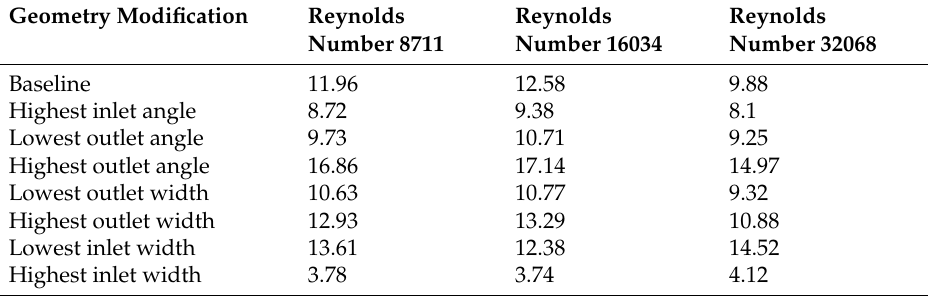
Table 7. Evaluation of the peak to peak net momentum amplitude at the (MC) incoming jet due to the pressure term, divided by the net momentum amplitude due to the (FC) mass flow term, and for the three Reynolds numbers